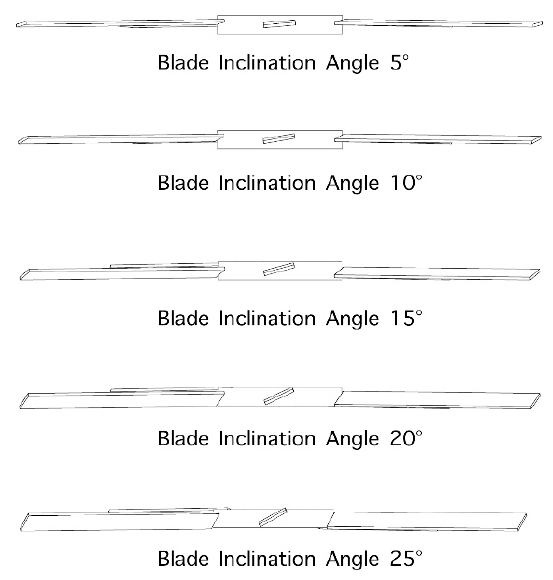
Figure 16. Different blade inclination angles used in the experiment.